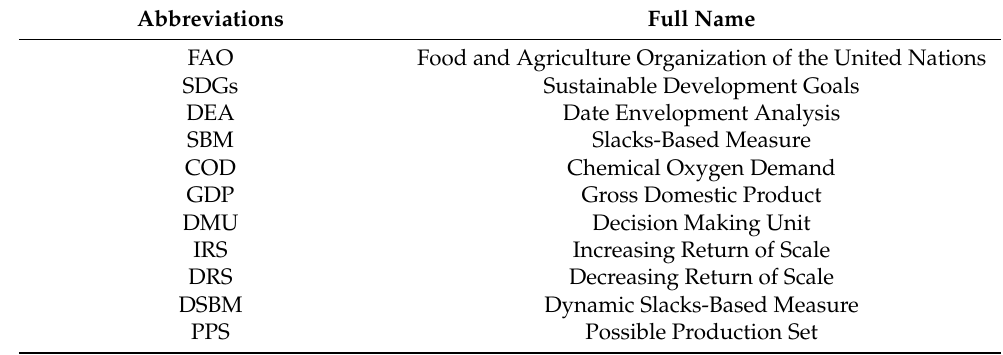
Table 1. Abbreviations used in full.